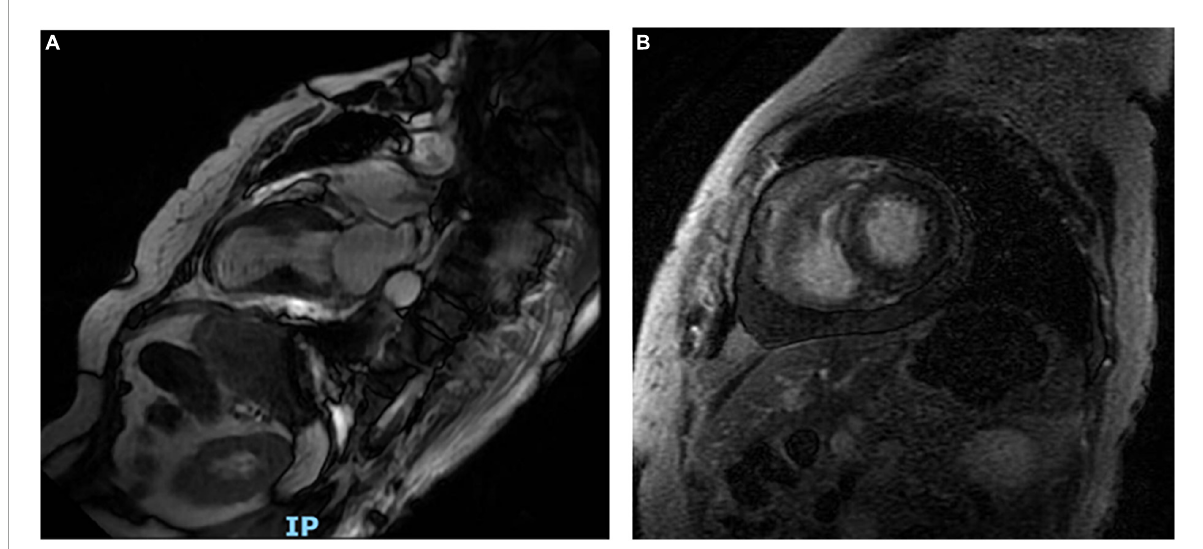
FIGURE4 Long-axis cardiac magnetic resonance shows the heart apex bulging toward the diaphragm (A) . Late gadolinium enhancement reveals a weakly enhanced interventricular septum (B) .